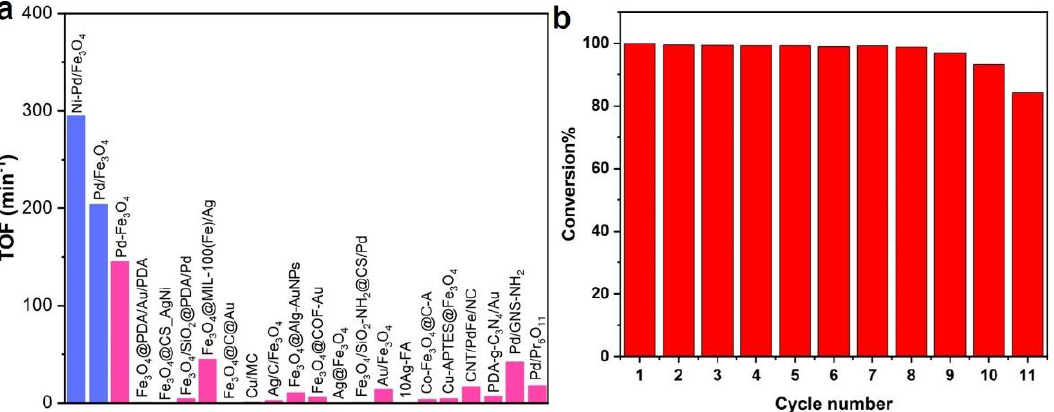
Figure 7. ( a ) The comparison of the catalytic activity (TOF) for the Ni-Pd/Fe 3 O 4 catalyst and the Fe 3 O 4 supported nanocatalysts reported within recent 5 years. Data adapted from Ref. [35,48 – 66] ( b ) Re-cycling of Ni-Pd/Fe 3 O 4 catalyst for the 4-NP reduction by NaBH 4 in each cycle.